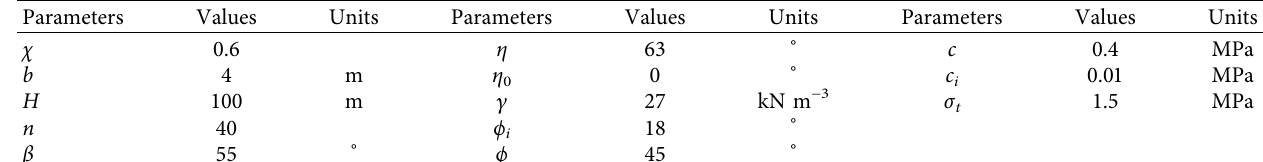
Table 1: Calculation parameters of rock mass of the slate slope in South Anhui in China [31].